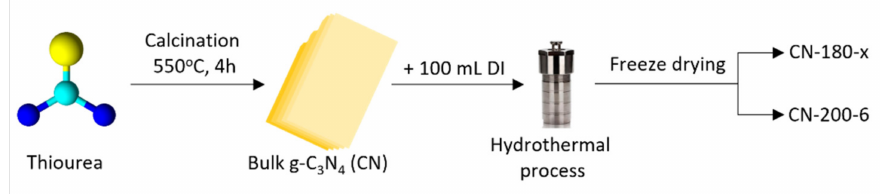
Figure 1. The synthesis of CN and